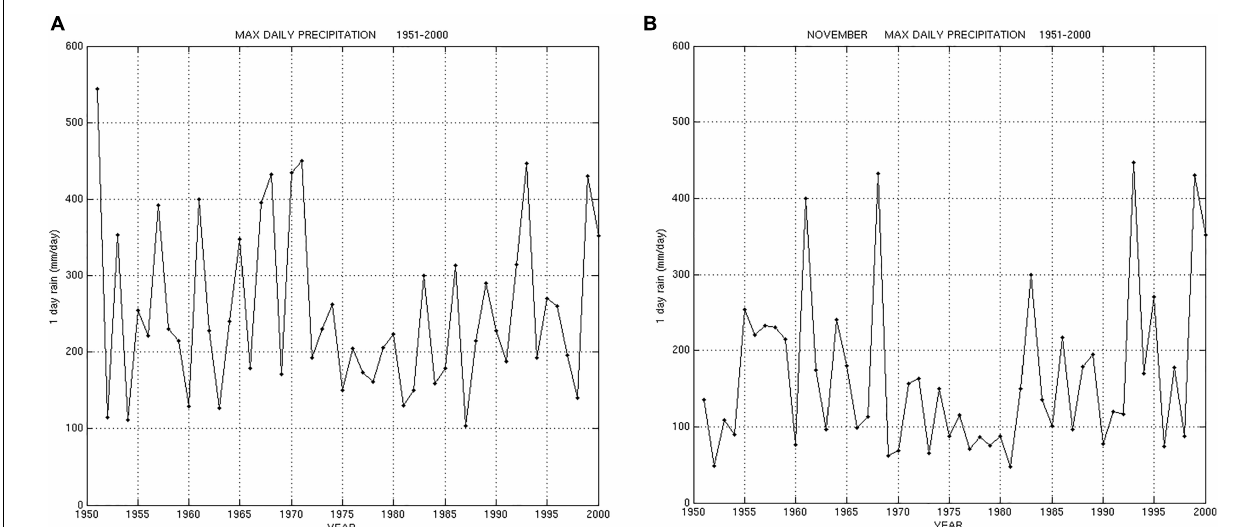
FIGURE 1 | (A,B) Yearly series and November series (1951–2000).